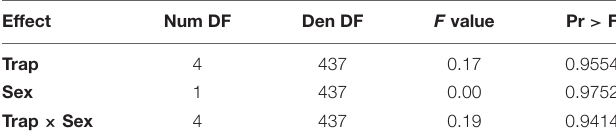
TABLE 7 | Type 3 analysis of effects of blueberry-fed flies in trap fluid.